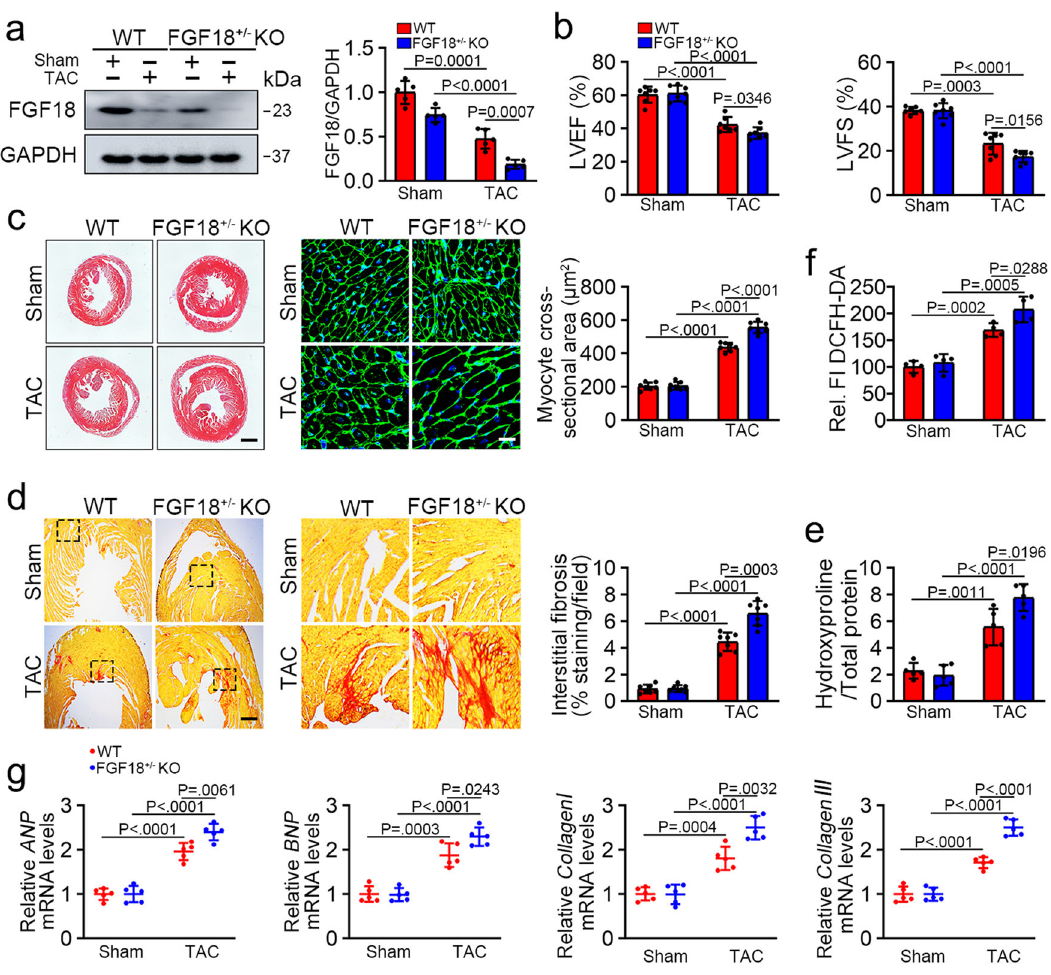
Fig.3|FGF18heterozygousexacerbatesthepathologyofcardiachypertrophy. FGF18 heterozygous mice ( Fgf18 +/ − mice) were subjected to Sham or TAC surgery and harvested after 6 weeks (Supplementary Fig. 7e). a Validation of FGF18 semi- knockout( Fgf18 +/ − KO )micebywesternblot.Quanti fi cationofrelativeproteinlevels (right panel). n =5. b LVEF and LVFS of WT and FGF18 +/ − KO mice as determined by echocardiography (Supplementary Fig. 7g). n =7. c Histological analyses of the HE staining and WGAstaining ( n =5.scale bar= 0.6mm for HEstaining;scale bar=20 μ m for WGA staining). Statistical results for the sectional cell area (right panel).